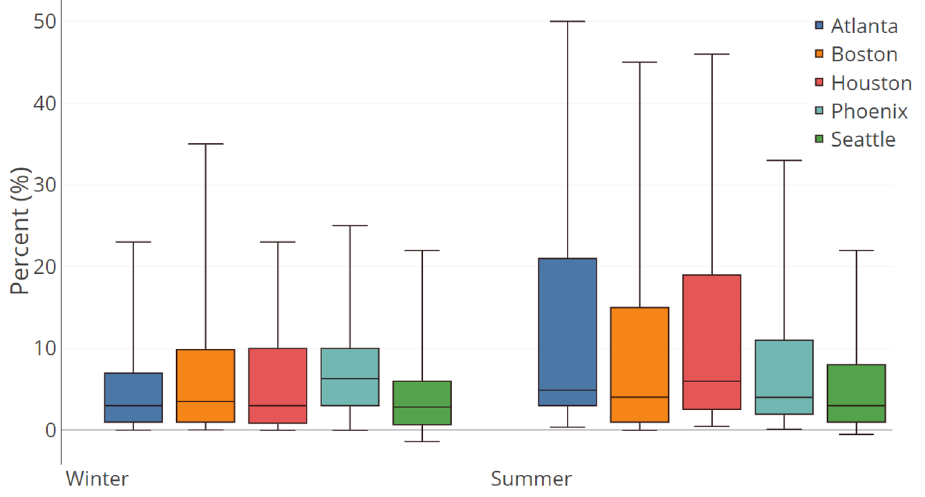
Figure 10. Unmet comfort and energy savings for simulation period, by city and season